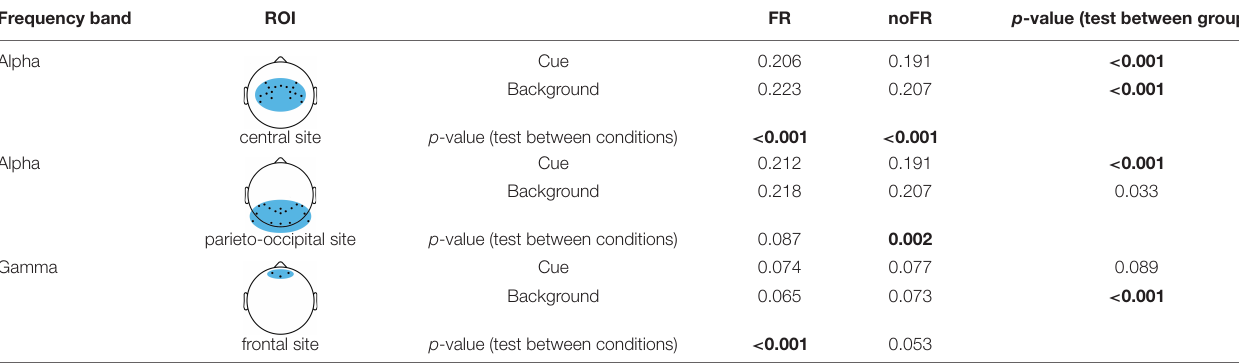
TABLE 5 | Results of statistical analysis of alpha and gamma’s RP in ROIs. Frequency band